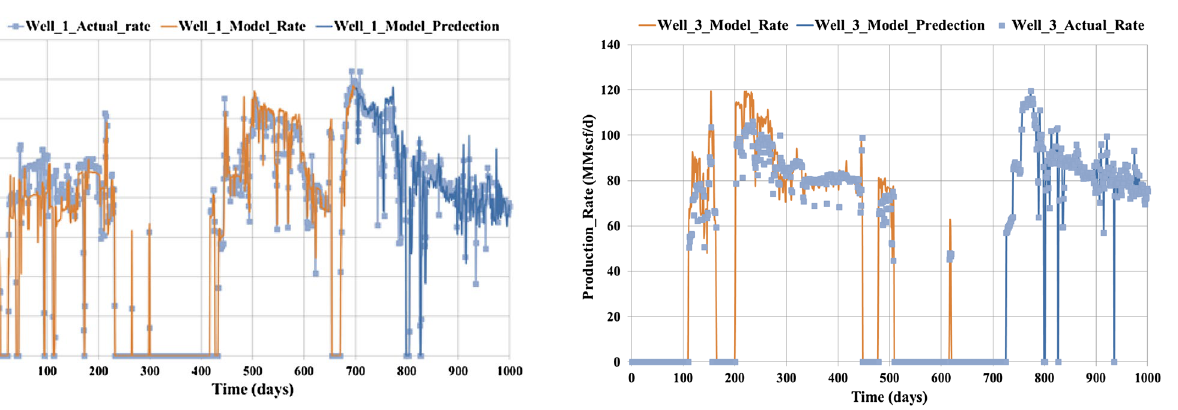
Fig. 4 Well 1 rate history match and prediction (case 1)